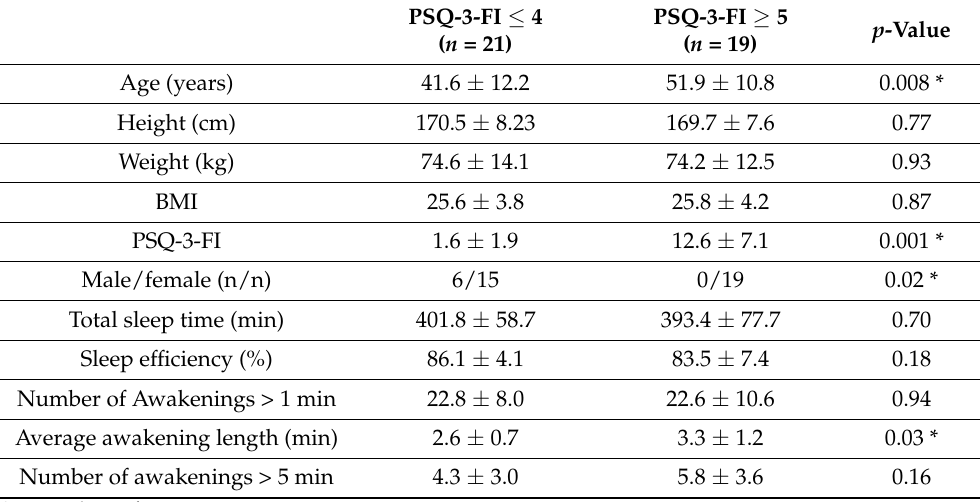
Table 7. Sleep quality measures based on actigraphy for the PSQ-3-FI score ≤ 4 and ≥ 5 groups ( n =